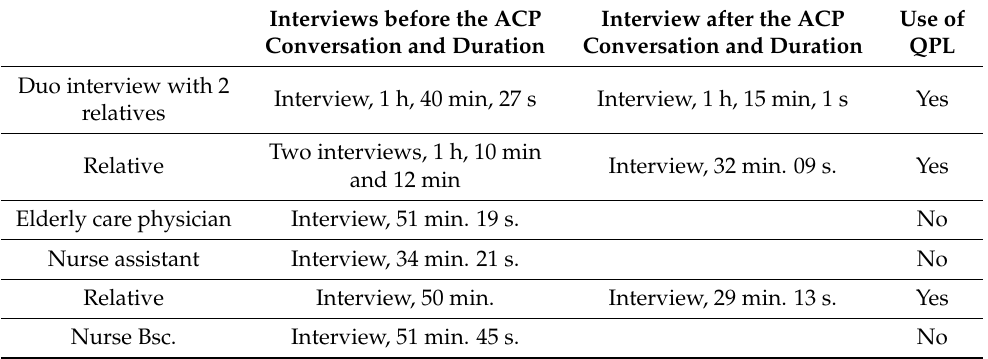
Table 2. The formal interviews during the ethnographic fieldwork. Interviews before the